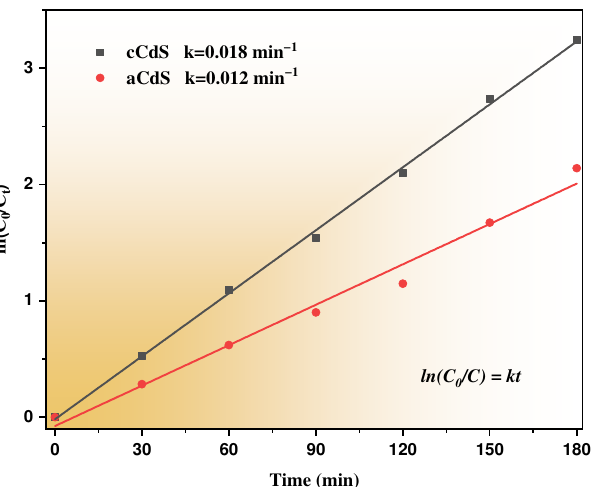
Figure 10. Photocatalytic degradation profiles of mechanochemically synthesized aCdS and cCdS catalysts under visible light irradiation.